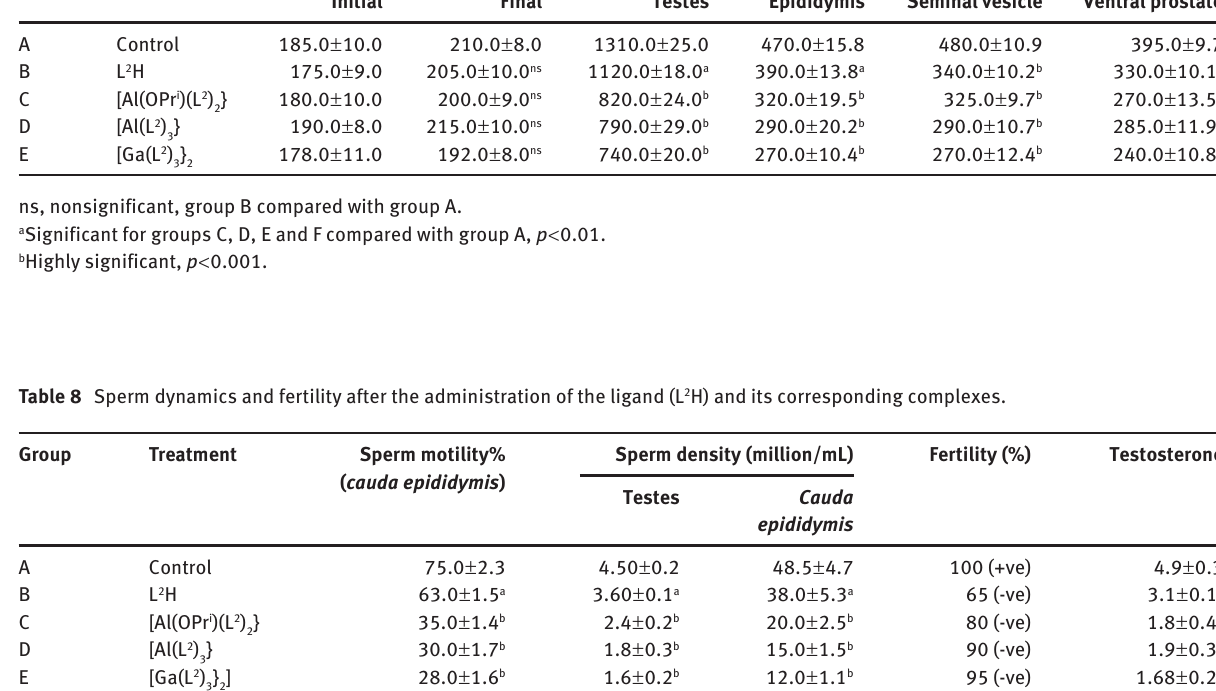
Table 7 Effect of the ligand (L 2 H) and its corresponding complexes on the reproductive organ weight of male rats. Group Treatment